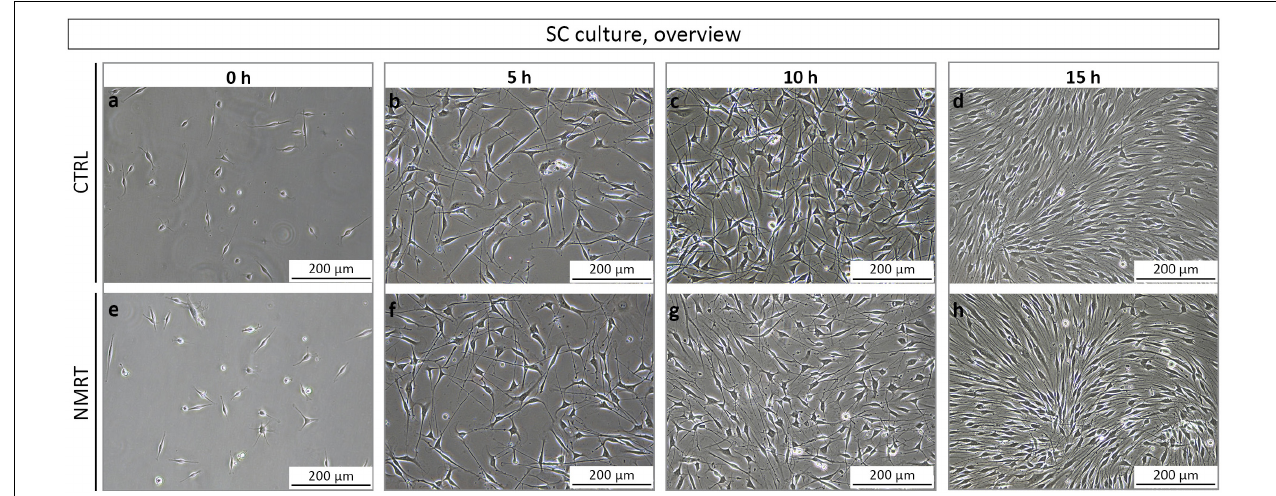
FIGURE 3 | Morphological analysis of SC cultures in response to NMRT. Representative phase contrast images illustrating a similar morphology of (a–d) control SC cultures (upper images) and (e–h) NMRT treated SC cultures (lower images) before treatment (0 h = 5 h after seeding) and after the 5, 10, and 15 h treatment